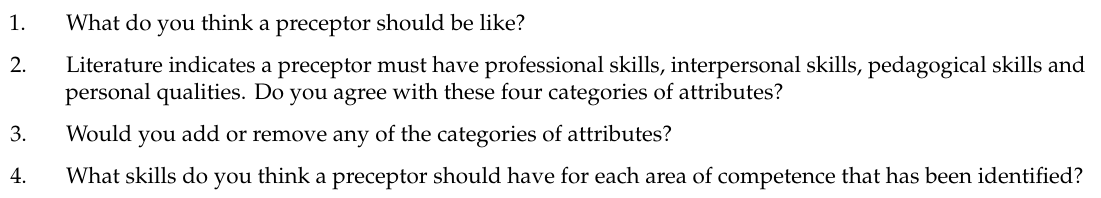
Table 1. Focus group